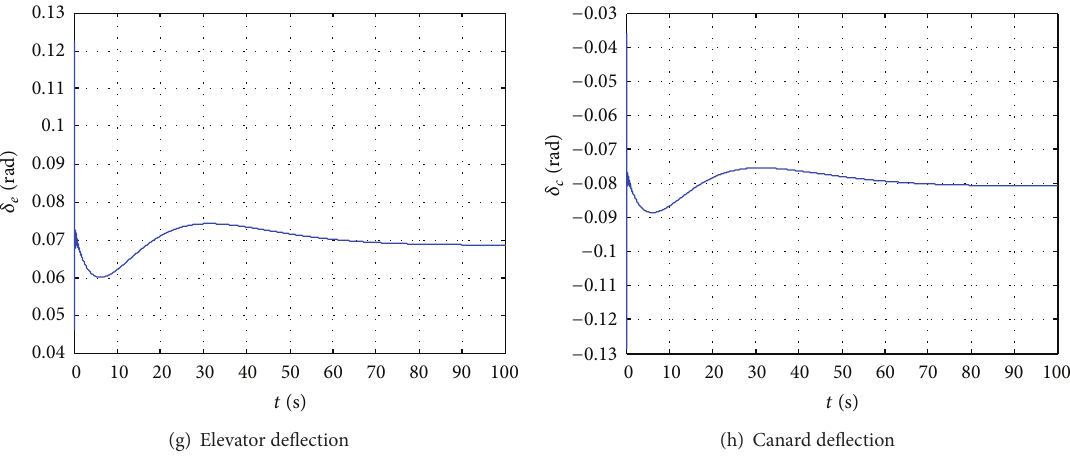
Figure 3: Descending maneuver with velocity reducing gradually for case